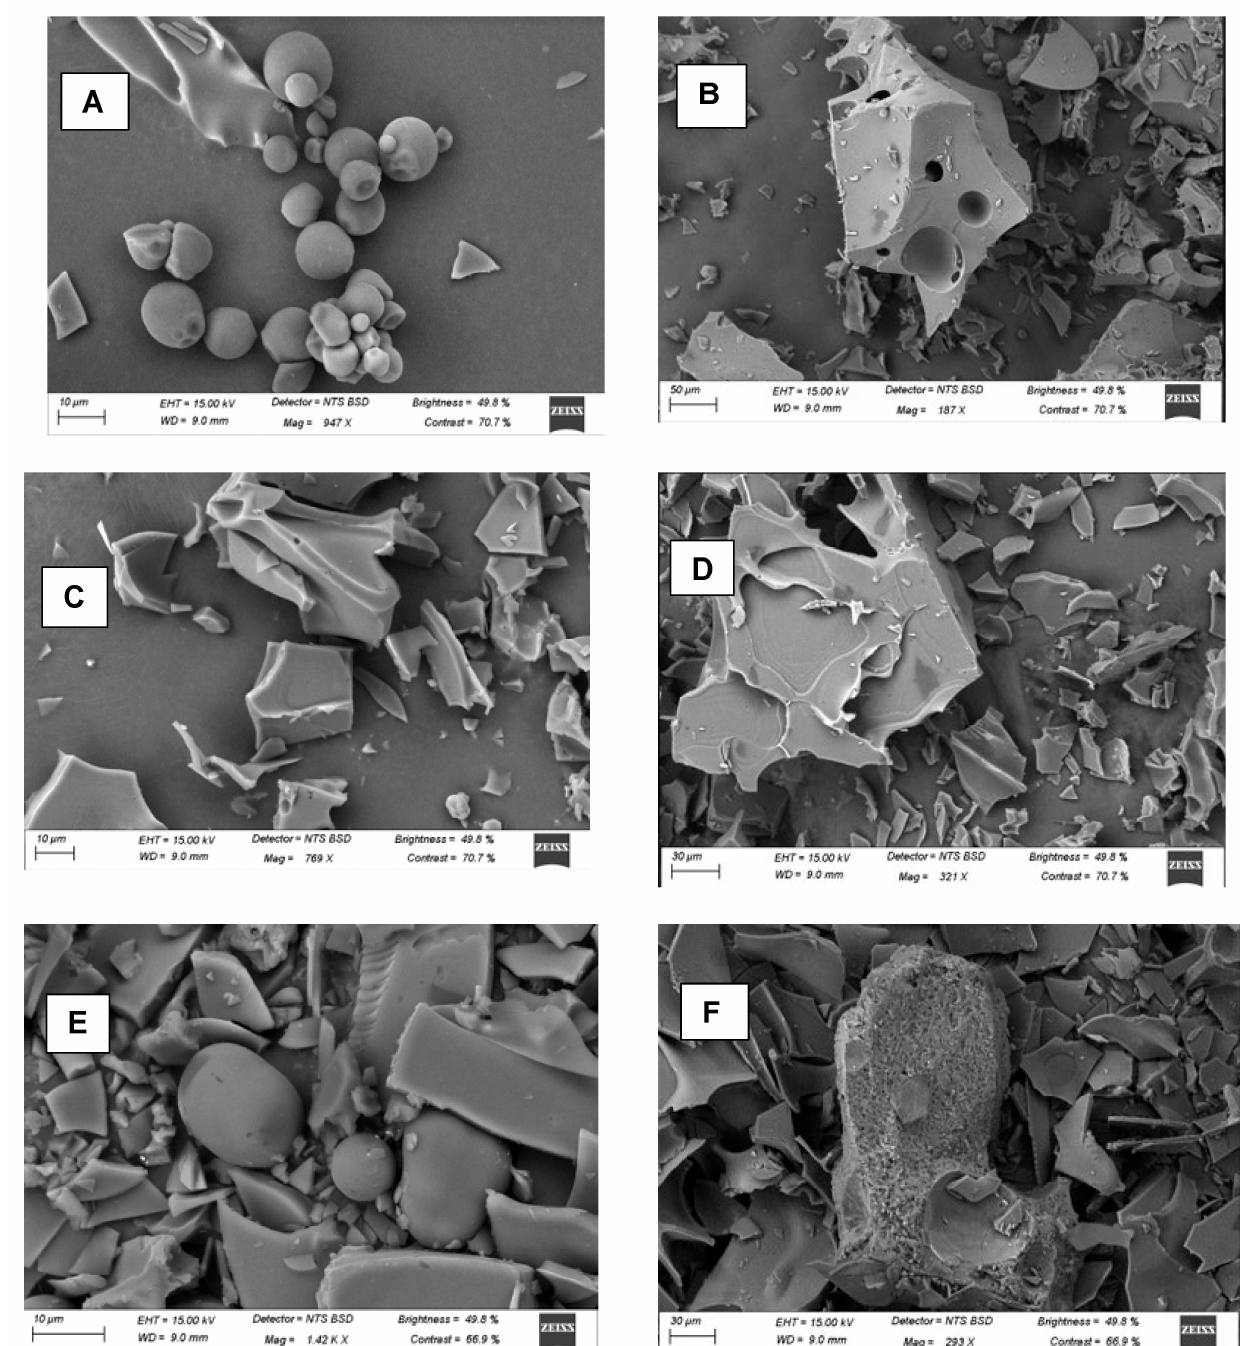
Figure 1. Morphological structures of microcapsules ( A , B ) MDGA ( C , D ) MD ( E , F ) GA.